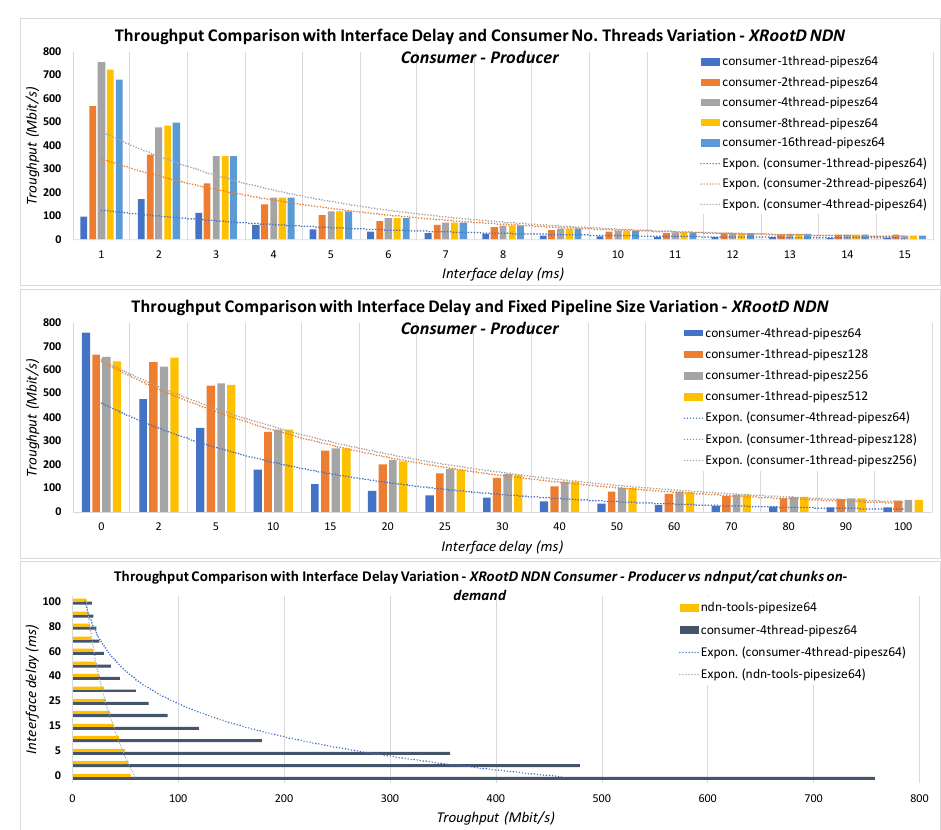
Figure 2: Performance analysis of the SANDIE consumer and producer applications The XRootD NDN based OSS plug-in performance was also compared against standard CMS tools: XRootD with a TCP based POSIX OSS plug-in and the Fast Data Transfer (FDT) [18] application. The same hardware configuration as in the previous analysis was used, with the same file sizes. The Xrdcp client was used in order to copy files using XRootD, which also o ff ers the possibility of varying the number of streams, a similar functionality to that found in FDT. The results can be observed in Figure 3, where the XRootD POSIX based plug-in has the best performance when interface delay is 2ms. It can also be observed that FDT performance is more stable with increased interface